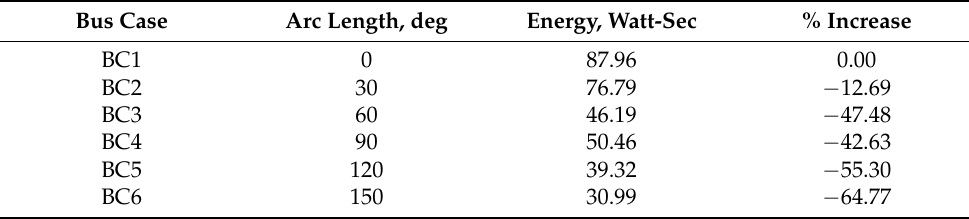
Figure 24. Instantaneous power of VAWT from Bus Cases 1 to 6 (BC1 to BC6). Table 4. Energy produced by VAWT in one pass of bus for each case.